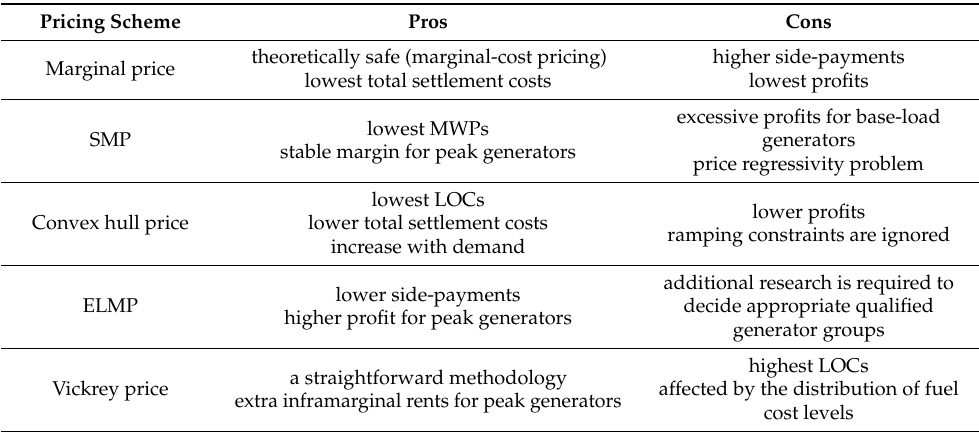
Table 7. Summary of features by market